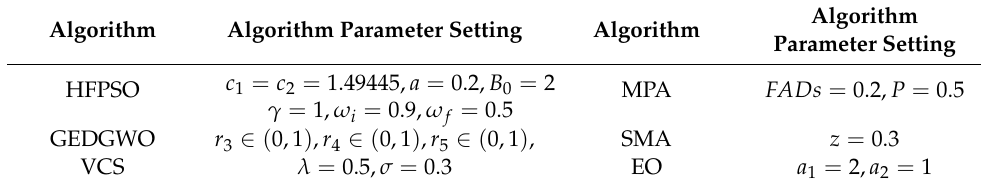
Table 1. Algorithm parameter setting. Algorithm Algorithm Parameter